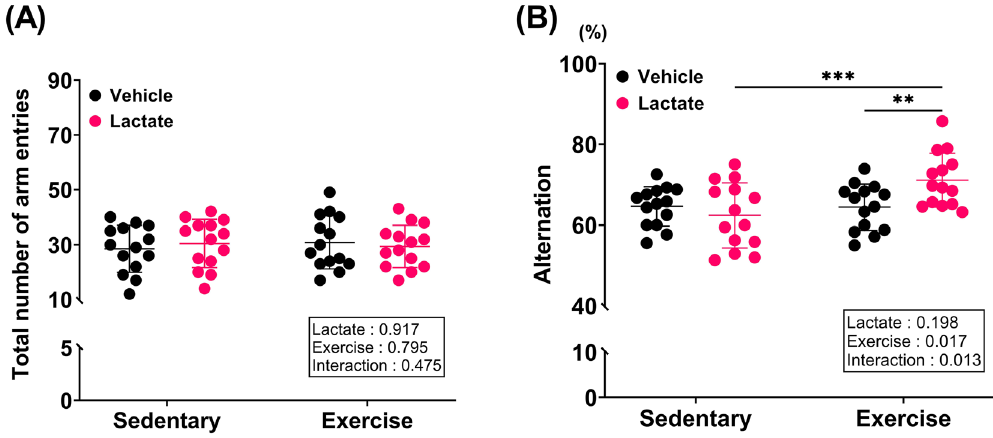
Figure 5. Exercise with lactate administration promoted spatial working memory. The test was conducted using Y-maze. ( A ) The total number of arm entries and ( B ) spontaneous alternation behavior (spatial working memory). Two-way ANOVA was performed, and independent Student’s t -test was used for post hoc test ( n = 14 per group). ** p < 0.01 and *** p ≤ 0.005. Data are presented as the mean ± standard deviation.